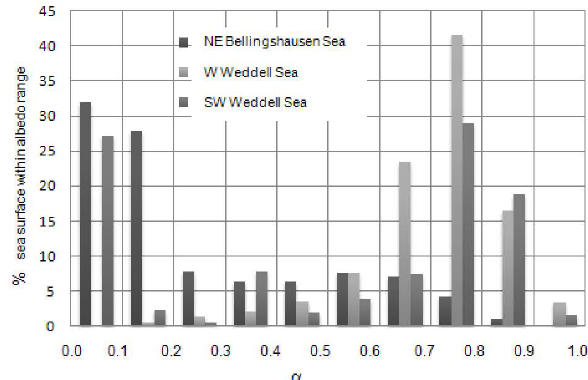
Fig. 3. Percentage of sea surface within a given albedo bin (1α =0.1) in the north-eastern Bellingshausen Sea, the western Weddell Sea and south-western Weddell Sea ice